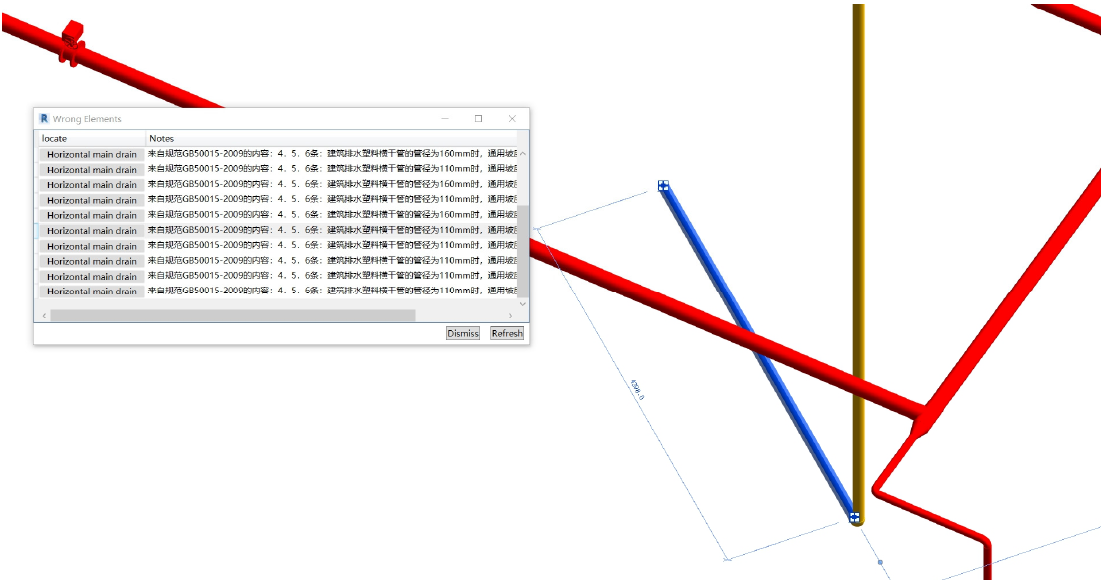
Figure 16. Checking results of the component property.